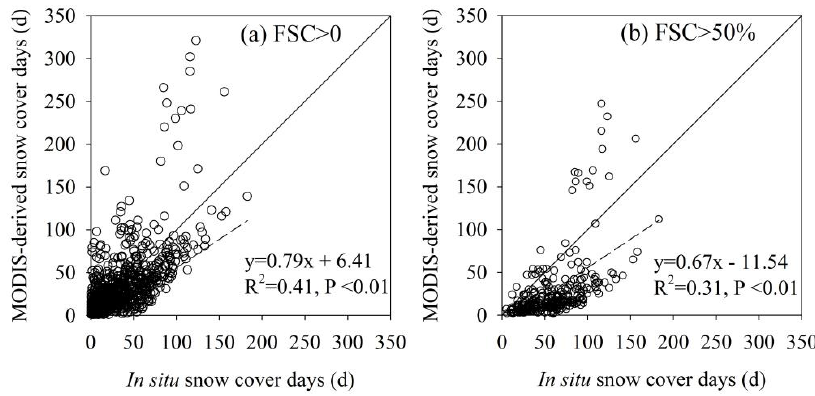
Figure 7. The relationship between in situ derived snow-cover days and MODIS-derived snow-cover days on the threshold of FSC >0 ( a ) and FSC >50% ( b ) in the Qinghai-Tibetan Plateau during 2000–2010. When choosing a threshold of FSC >0 (data from 71 sites were available), the MODIS product resulted in an earlier snow starting time at 59.15% of the stations, an earlier snow ending time, and a longer snow-cover duration at 56.34% of stations, as compared with in situ observations (Figure 8a– c). On the contrary, when choosing a threshold of FSC >50% (data from 40 sites were available), the MODIS product showed a later snow starting time at 75.0% of stations, an earlier snow ending time at 95.0% of stations, and a shorter snow cover duration at 95% of stations, as compared with the in situ observations (Figure 8d–f). On the threshold of FSC >0, the MODIS product underestimated the snow starting time and snow ending time, while overestimating the snow-cover duration at about half of the sites. These underestimated or overestimated stations were primarily located in lower- latitude regions, especially in the southeastern portion of the QTP (Figure 9). Similarly, on the threshold of FSC >50%, the MODIS product overestimated the snow starting time, but underestimated the snow ending time and the snow-cover duration in mid-latitude regions (Figure 9).